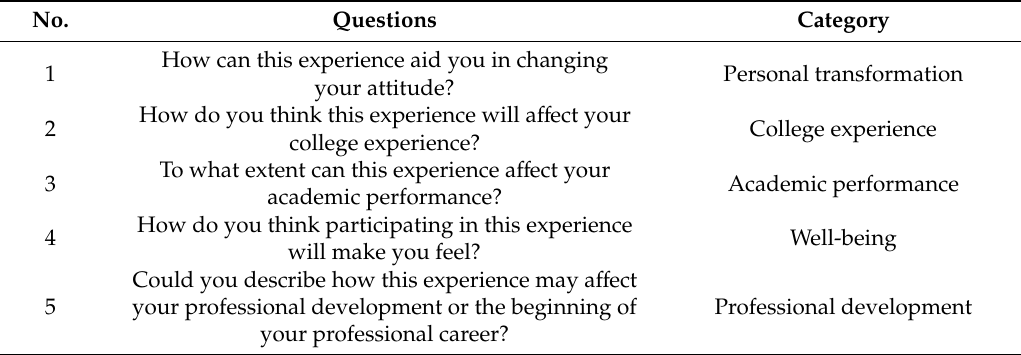
Table 2. Question script used in the semi-structured